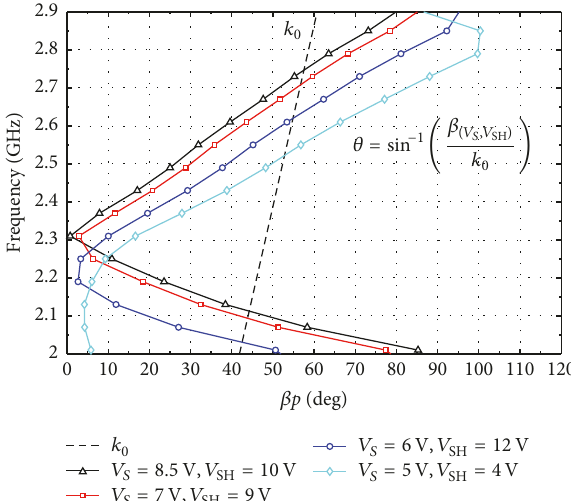
Figure 7: Dispersion diagram of the proposed miniaturized CRLH unit cell. The four different states were taken for incremental values of bias voltages 𝑉 𝑆 𝑉 SH . The desired frequency bandwidth, 2.41–2.48 GHz, falls within the RH radiated